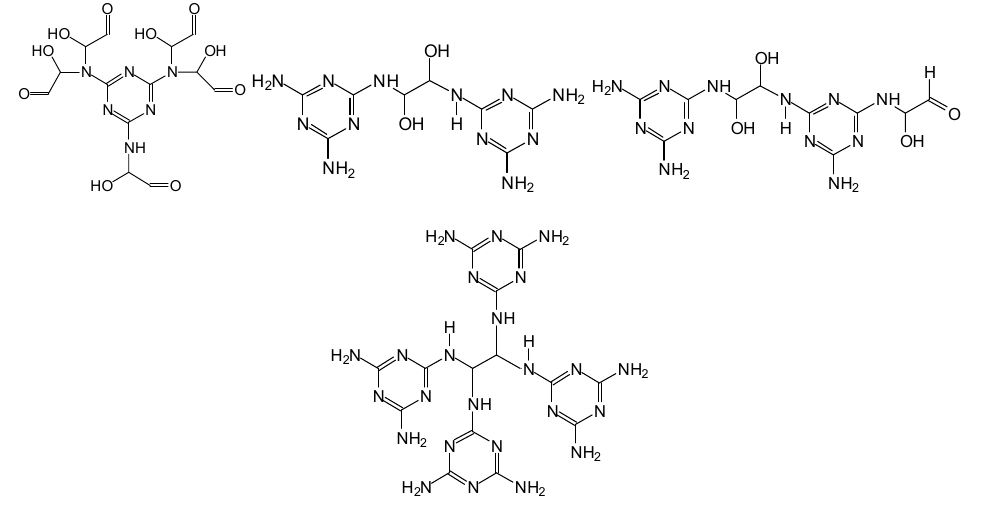
O Scheme 7. Oligomers formed in MGG’ resins showing reaction of glutaraldehyde and glyoxal Where a glutaraldehyde is linked to a melamine of a MG resin skeleton. Also species in which an aldehyde that has undergone aldol condensation has reacted and linked with the melamine are present in the MGG’+IL resins. For example the peak at 356–357 Da (333 + 23 Da of Na + ) in Figure 6 represent just one of these species issued by the aldol condensation of three glyoxals linked to a melamine molecule. Aldehydes react readily with melamine, but when a dialdehyde reacts after one of the two aldehyde groups has reacted and before the second one reacts aldol condensation can occur involving this second, still free aldehyde group. Thus either (i) the glyoxal units have condensed by aldol condensation for subsequently the residual aldehyde group to react with melamine; or (ii) one glyoxal molecule has reacted with melamine and the other glyoxals have then reacted on the residual aldehyde function by aldol condensation (Scheme 8).